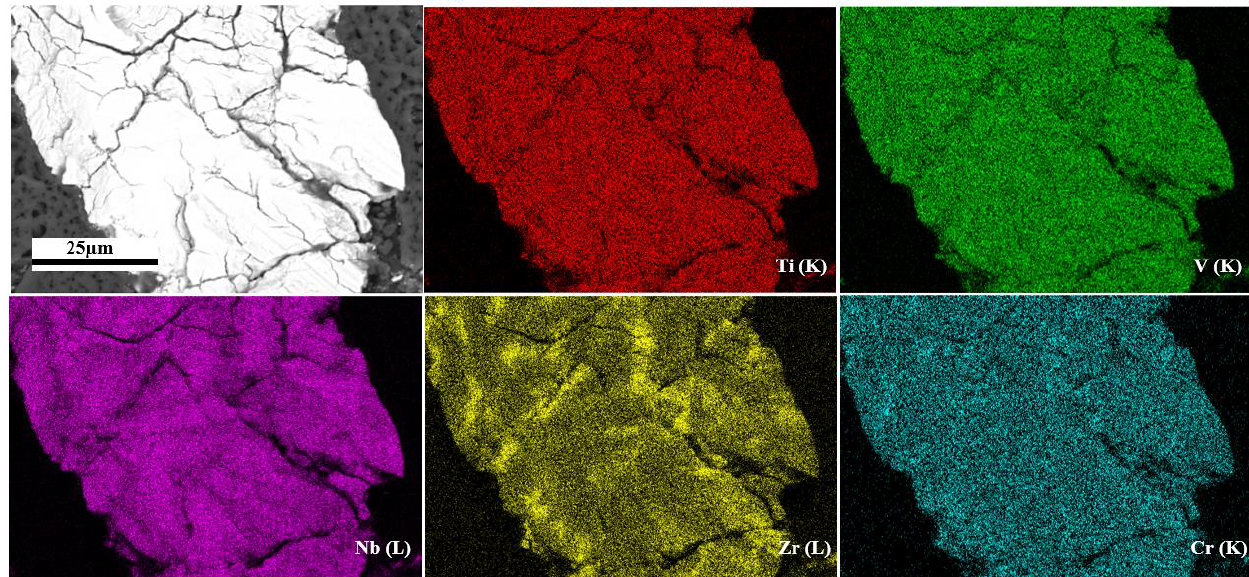
Figure 9. EDS chemical mapping and scanning electron microscopy image of the Ti 0.30 V 0.25 Cr 0.10 Zr 0.10 Nb 0.25 alloy after 20 hydrogen absorption/desorption cycles.